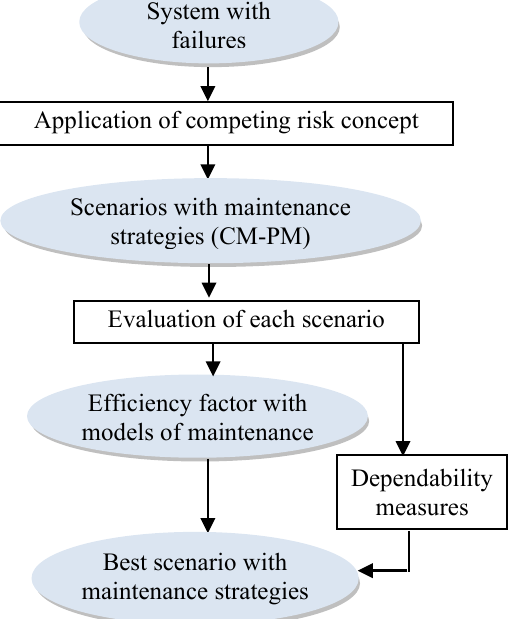
Figure 1. Methodology of proposed